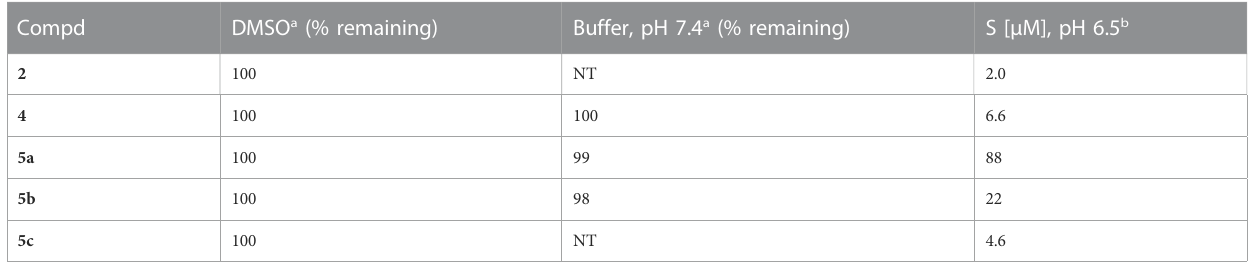
a HPLC, analysis of in vitro stability after 24 h at room temperature. b Thermodynamic solubilities in Britton-Robinson buffer (pH 6.5). Values are the average of two measurements.